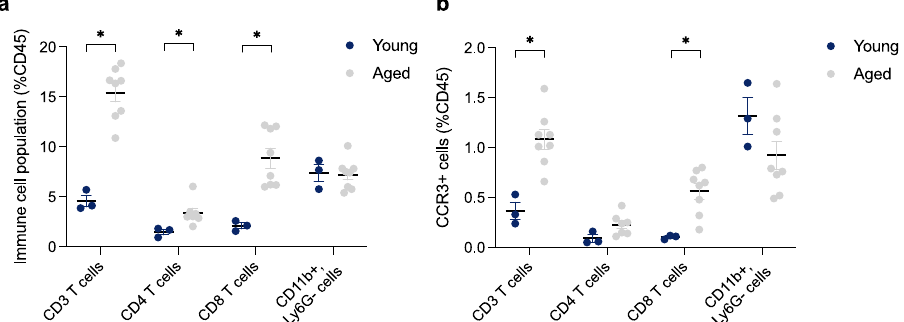
Fig. 4 CCR3-expressing T cells increase with age in the choroid plexus. Flow cytometric analysis of surface markers in pooled choroid plexus samples from young (average age of 5 months) and aged (29 month) C57Bl/6 mice. Single cells isolated from pooled choroid plexus samples were stained for markers of interest on T cells (CD3 + ), T helper cells (CD3 + CD4 + ), Cytotoxic T cells (CD3 + CD8 + ) and Myeloid cells (CD11b + Ly6C − ). a Respective frequencies of cell populations were normalized to total CD45 + cells for T cell populations and Myeloid cell populations (* p < 0.05, multiple Mann – Whitney test, n = 3, 8). b Flow cytometric analysis of CCR3-expressing cells normalized to total CD45 + cells in T cell populations and Myeloid cell populations (* p < 0.05, multiple Mann – Whitney test, n = 3, 8). All data shown are mean ± standard error of the mean.